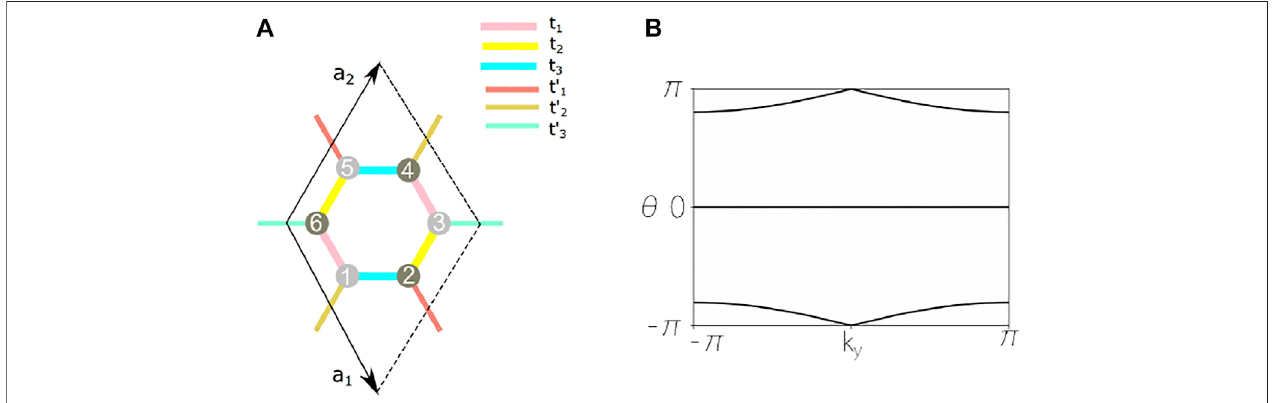
FIGURE1 |(A) Schematic ofthe honeycomb-latticemodel. t i representsintracellhoppings and t i ′ representsintercellhoppings with i =1, 2,3. The sixatomic sites in a unit cell can be divided into two sublattice, as marked by the gray and brown circles, so that a site in one sublattice has all its nearest neighbors from the other sublattice. (B) ThewindingofWilsonlooparound k y fortopologicalnontrivialcase.TheWilsonloopiscomputedalongalargecircleparametrizedby k x for fi xed k y (where k x , y representsperiodicdirectionalong a 1 , a 2 or a 3 ).Theloopexhibitsacrossat θ = π and k y =0,whichmeansthe Z 2 topologicalinvariant ] =1.Theparametersare set as t 1 (cid:2) t 2 (cid:2) t 3 (cid:2) 1 , t 1 ′ (cid:2) t 2 ′ (cid:2) t 3 ′ (cid:2) 3.